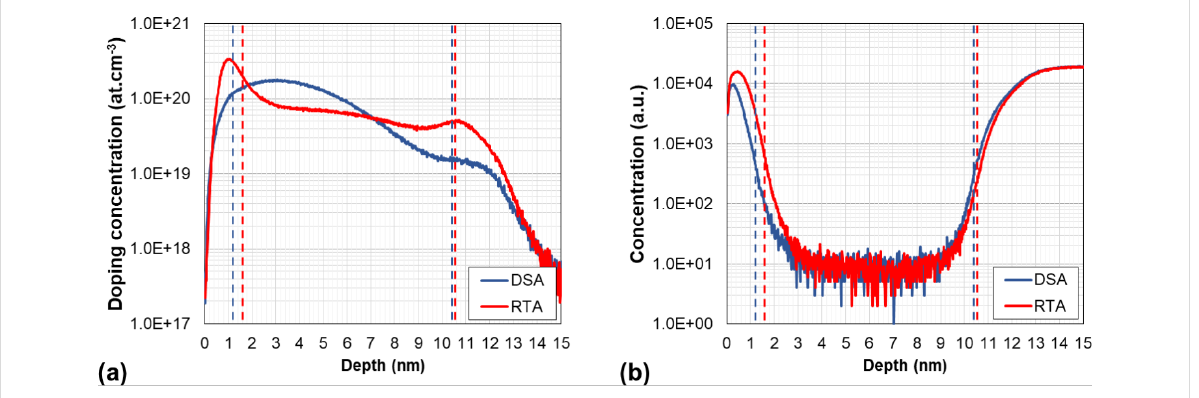
Figure 8: Concentration depth profiles of (a) arsenic and (b) oxygen measured by SIMS in 11 nm thick SOI wafers implanted with arsenic and annealed by RTA (red curves) or DSA (blue curves).